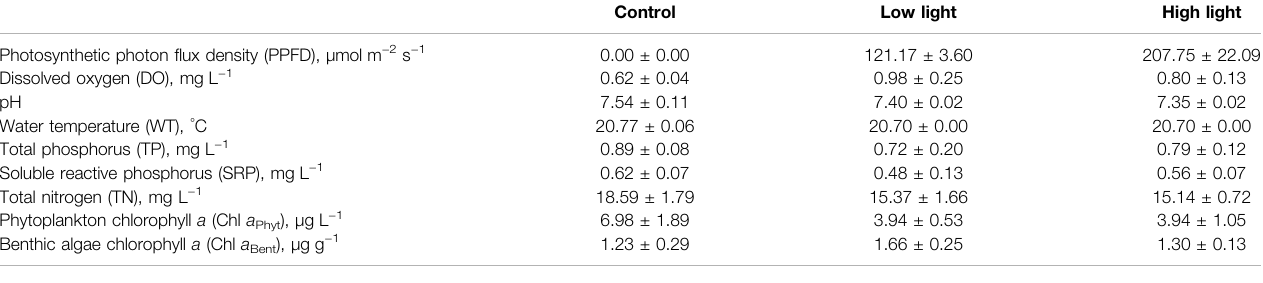
TABLE 1 | The initial (18 November 2020) conditions of the experimental systems (mean ± SD).